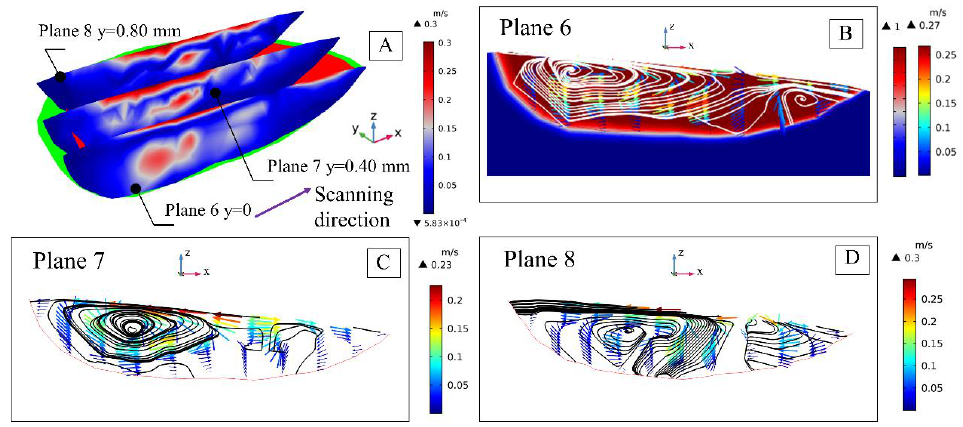
Figure 9. Melt pool profile, cross − section coordinates and velocity distribution on xy-plane. ( A ) Melt pool configuration and position of two xy-sections; ( B ) Velocity distribution at plane 4; ( C ) Velocity distribution at plane 5.